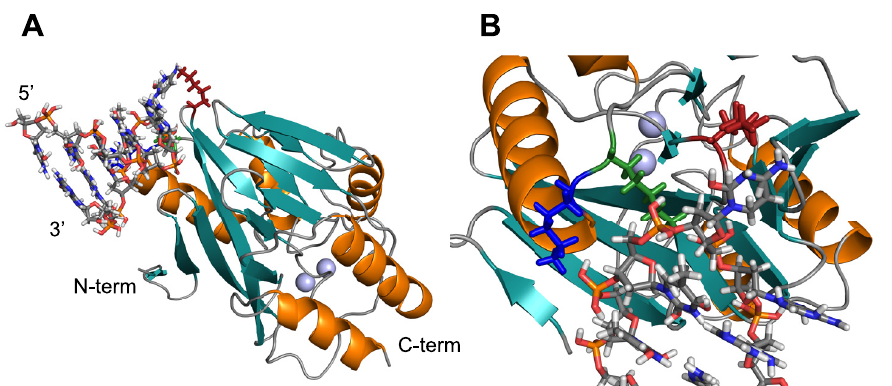
Fig 5. Model of the 10-mer bound to 5/B/6 MBL provides a picture of the inhibited state. Model of the 10-mer bound to 5/B/6 MBL. The lowest energy HADDOCK structure is given, while a representative structure from the seven other clusters is given in S5 Fig. The coloring of secondary structural elements for the 5/B/6 MBL follows Fig 2, and the red, blue and green sticks denote K78, K104, and K107, respectively. The 10-mer is shown as salmon sticks and the two Zn 2+ ions are light blue spheres. A) The overall structure of the enzyme-10-mer complex. B) A closer view of the enzyme-10-mer interaction